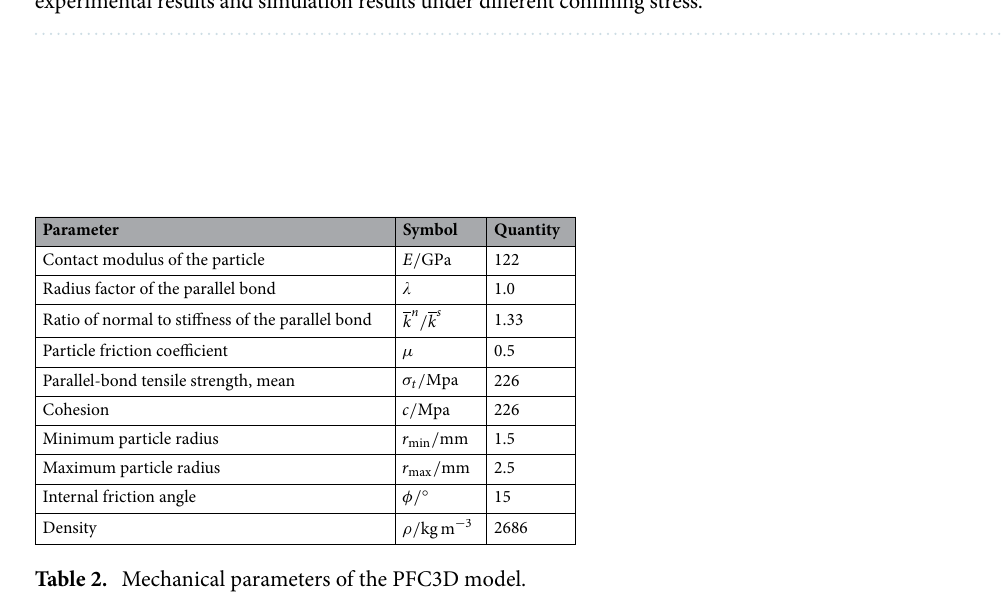
Figure 7. Compression test results of granite obtained from experiments and our simulation model. ( a ) Stress–strain curves of compression tests and simulation results; ( b ) Comparison of the strength envelops of the experimental results and simulation results under different confining stress.